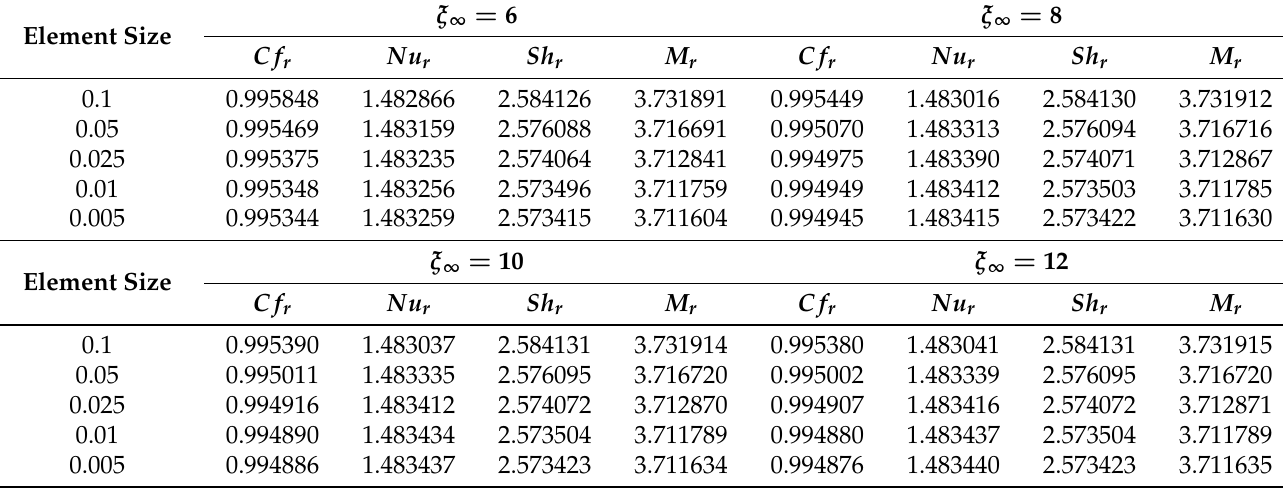
Table 2. Mesh independency test with linear shape function ( m = 2) and boundary layer thickness ( ξ ∞ ). Element